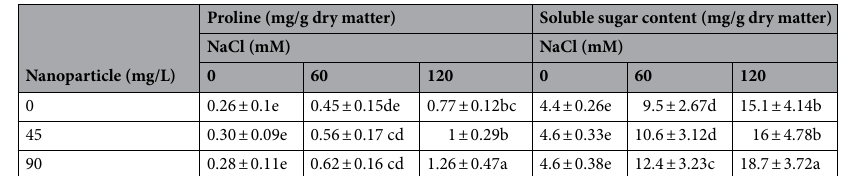
Table 3. Effect of salinity stress and nanoparticle interaction on shoot proline and soluble sugar content in Roselle.